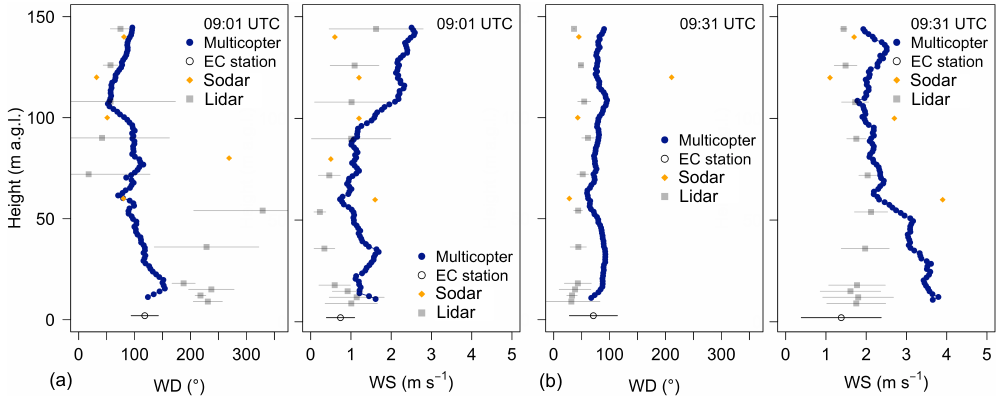
Figure 6. Wind direction and speed profiles during two different flights: 09:01UTC (a) and 09:31UTC (b) on 15 July 2015. The blue profiles show multicopter data, dark grey circles represent EC station data, light grey squares lidar data and orange squares sodar data. Lidar and EC station data were averaged over the time the multicopter needed for the profile. Error bars show their standard deviation.